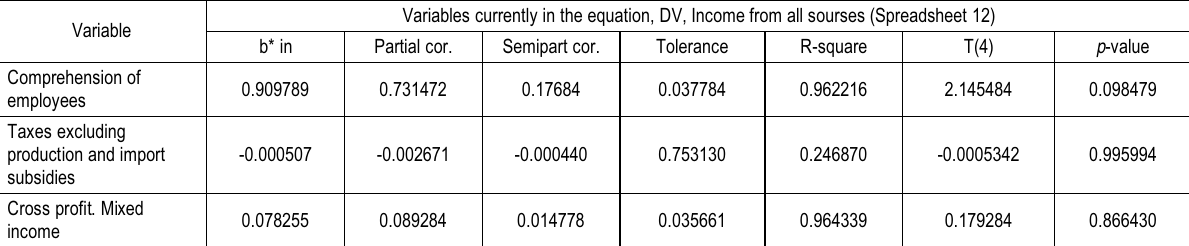
Table 3.The values of the partial correlation coefficients are presented in the column “Partial cor.”